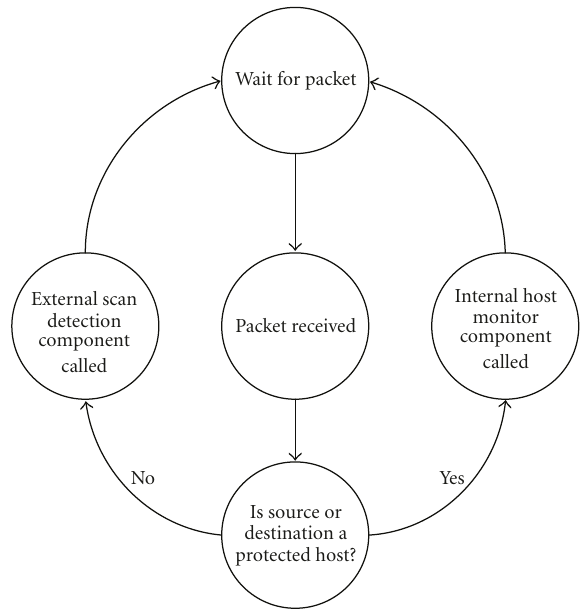
Figure 1: Component selection state